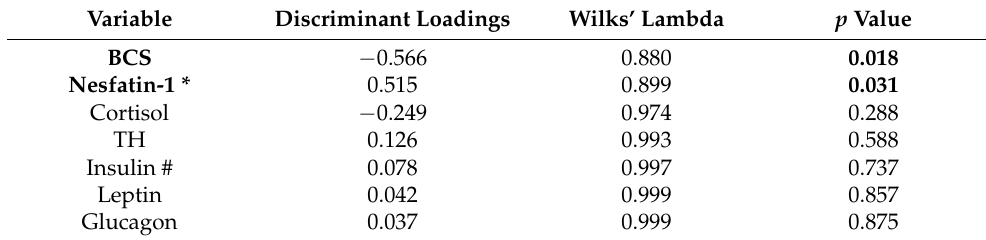
Table 1. Parameters indicating the relative importance of variables in classifying the ewes receiving nutritional supplementation: discriminant loadings, Wilks’ Lambda, and significance of the F test ( p -value). The variables with a significant F-test are in bold. Variable Discriminant Loadings Wilks’ Lambda p Value BCS − 0.566 0.880 0.018 Nesfatin-1 * 0.515 0.899 Cortisol −